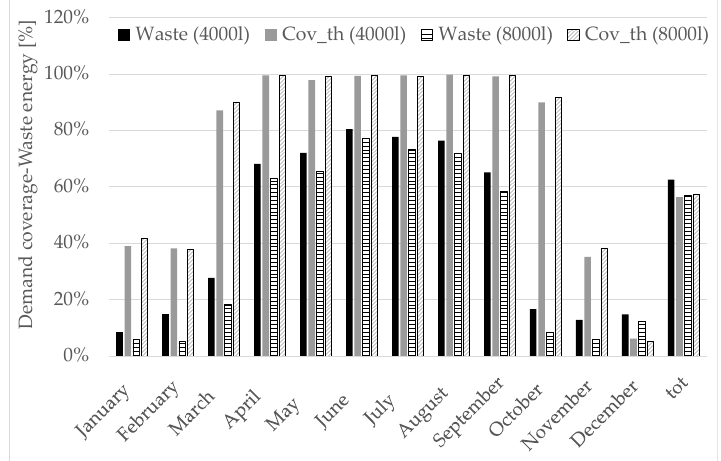
Figure 5. Monthly thermal energy wasted and total energy demand coverage for the case of a terraced house in Ancona with a thermal energy storage (TES) volume of 4000 L (standard configuration) and with a TES volume of 8000 L (double size compared to the standard configuration).